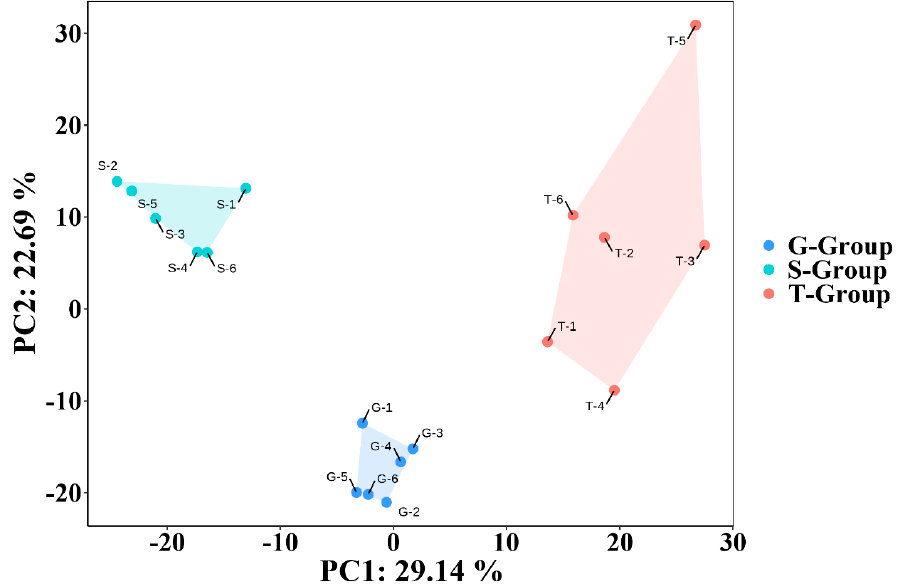
Figure 3. The effects of different cultivation methods on the metabolite profile ( n = 6). PCA was used to analyze the data. The contribution of PC1 was 29.14% and that of PC2 was 22.69%. Each point represented one sample. G-Group meant that the sample was from greenhouse cultivation; S-Group meant that the sample was from stone epiphytic cultivation; T-Group meant that the sample was from live tree epiphytic